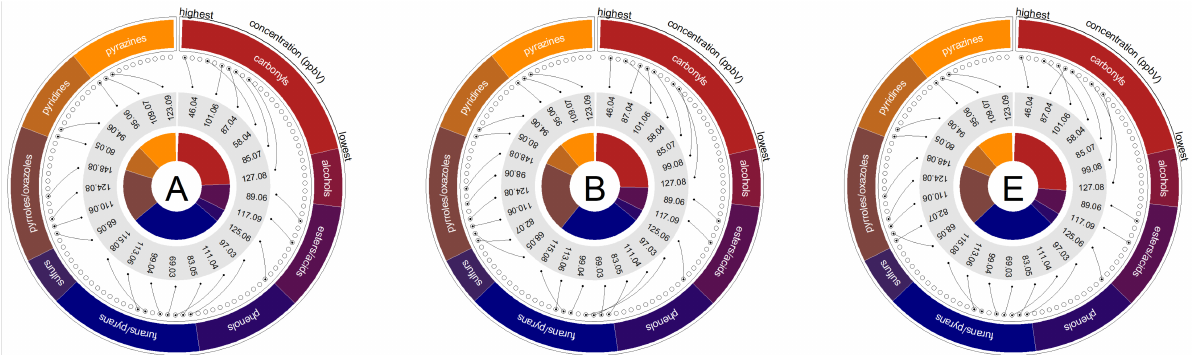
Figure 3. Circular plots. For each coffee, the composition of the headspace and the nosespace are represented by the outer and inner circles, respectively. Masses are sorted according to chemical class and relative abundance. When the same masses are detected in both experimental modes, these are linked by a continuous